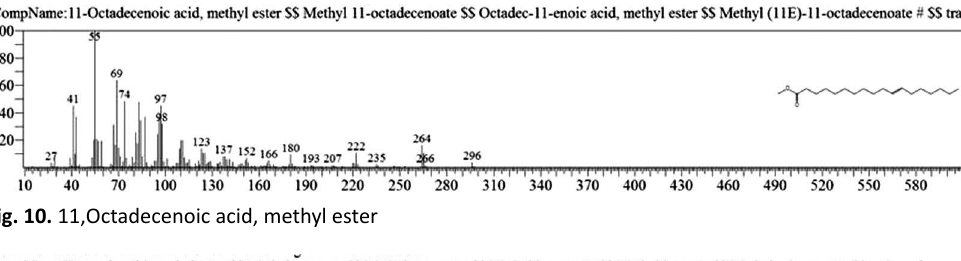
Fig. 9. 9,12-Octadecadienoic acid (z,z).,methyl ester